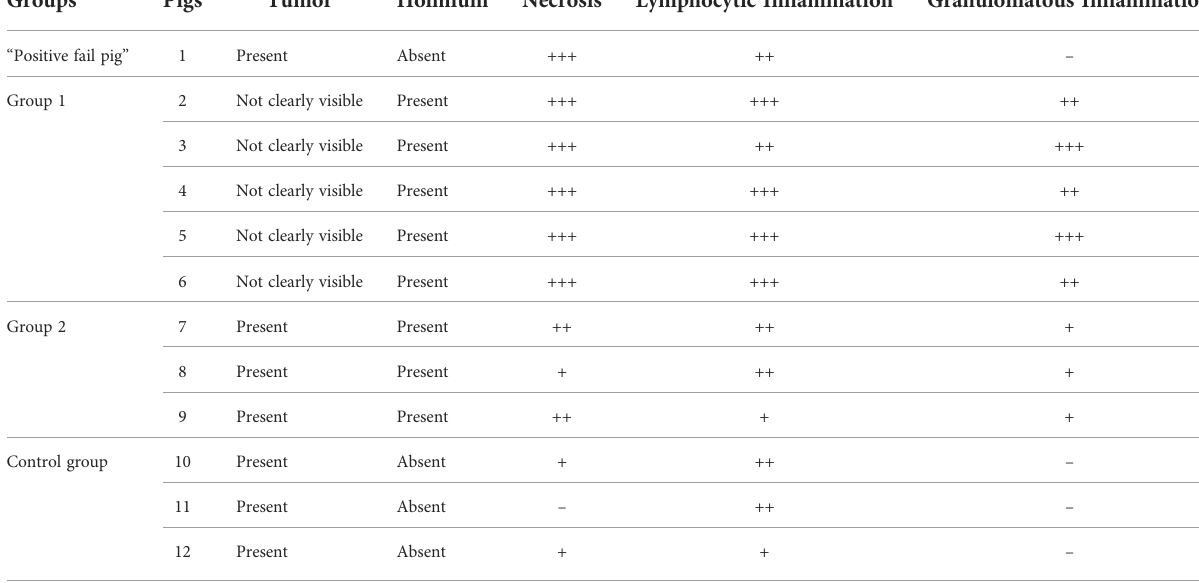
TABLE 5 The fi ndings observed on H&E slides in the brain of the animals in groups 1, 2, control group and positive fail pig. Groups Pigs Tumor Holmium Necrosis Lymphocytic In fl ammation Granulomatous In fl ammation